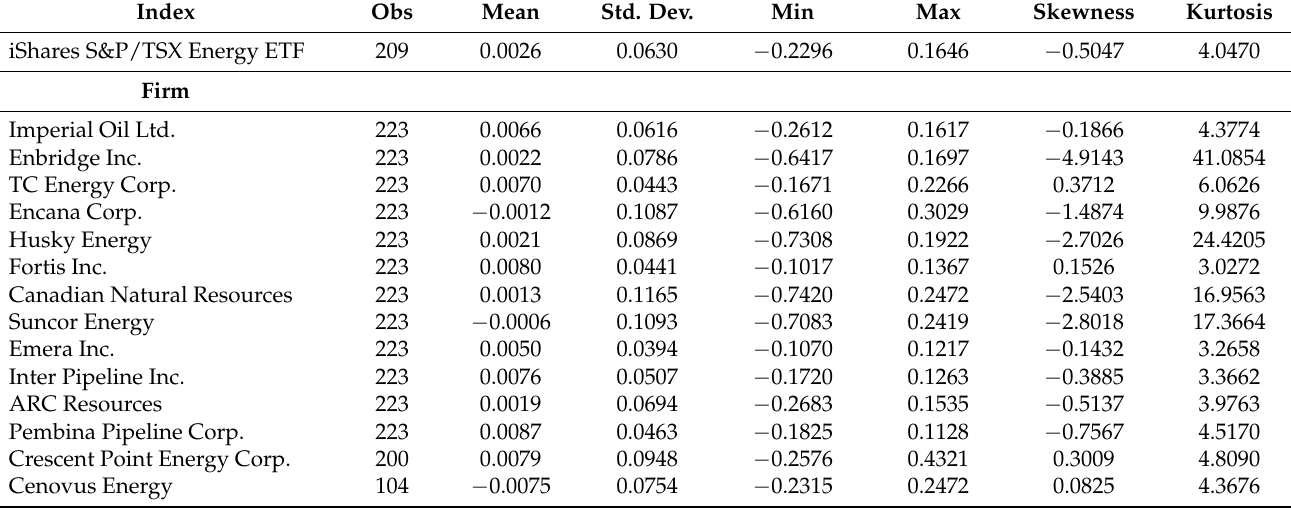
Table 1. Summary statistics of monthly log returns, Fama–French and oil